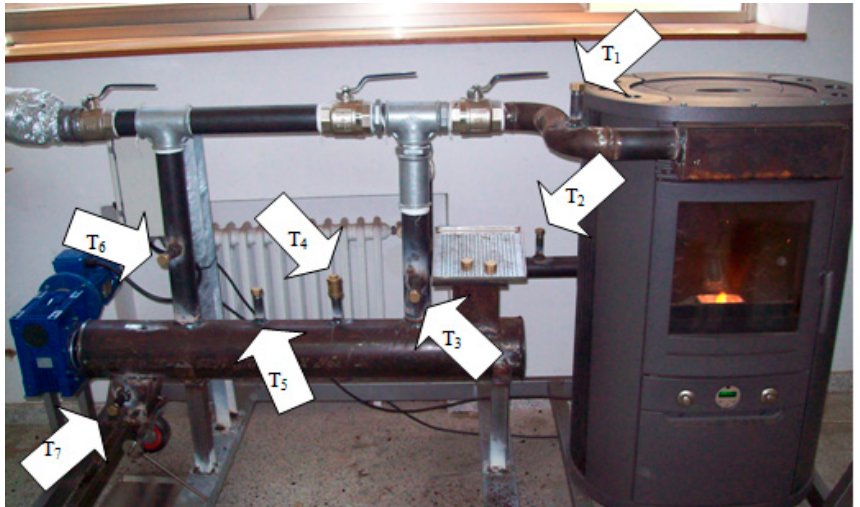
Figure 3. Laboratory experimental facility. T 1 : temperature of hot air; T 2 : temperature of hot gas chimney; T 3 : temperature of a dryer gas inlet; T 4 : temperature of first measurement point; T 5 : temperature of second measurement point; T 6 : temperature of a dryer gas outlet; and T 7 : temperature of an olive pomace outlet.